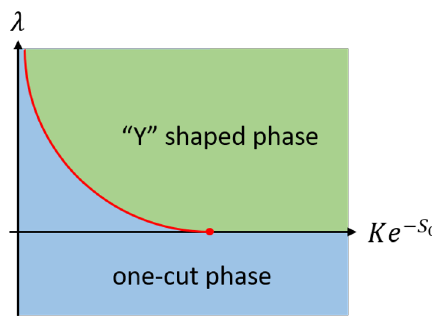
Figure 1. The phase diagram of matrix model of JT gravity with K flavors of EOW branes. Green region is “Y” shaped phase, blue region is one-cut phase and red curve is critical